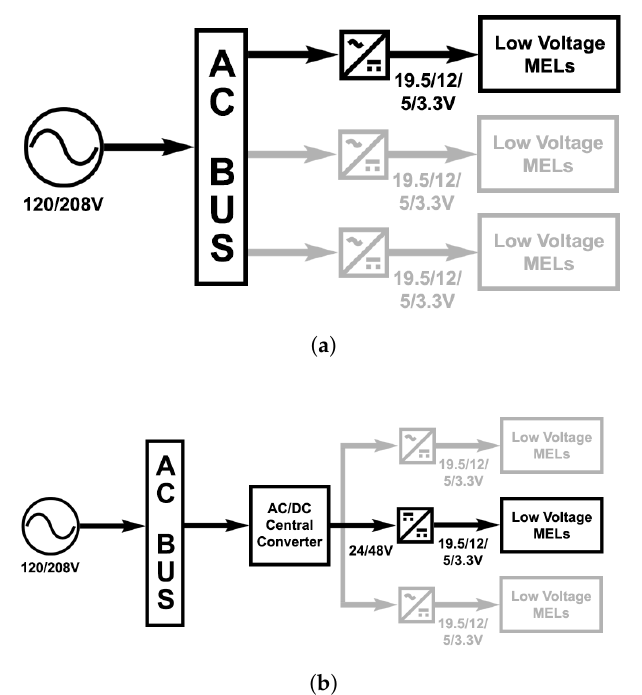
Figure 2. Typical ( a ) AC and ( b ) DC distribution for commercial